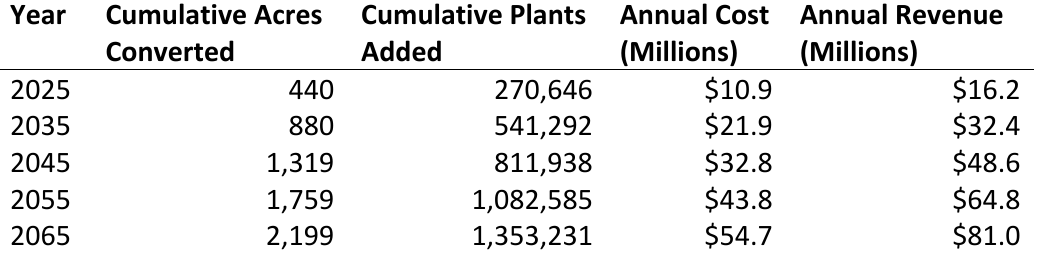
Table A1.9. Annual revenue and costs for coffee scenario (RCP 8.5 mid century)